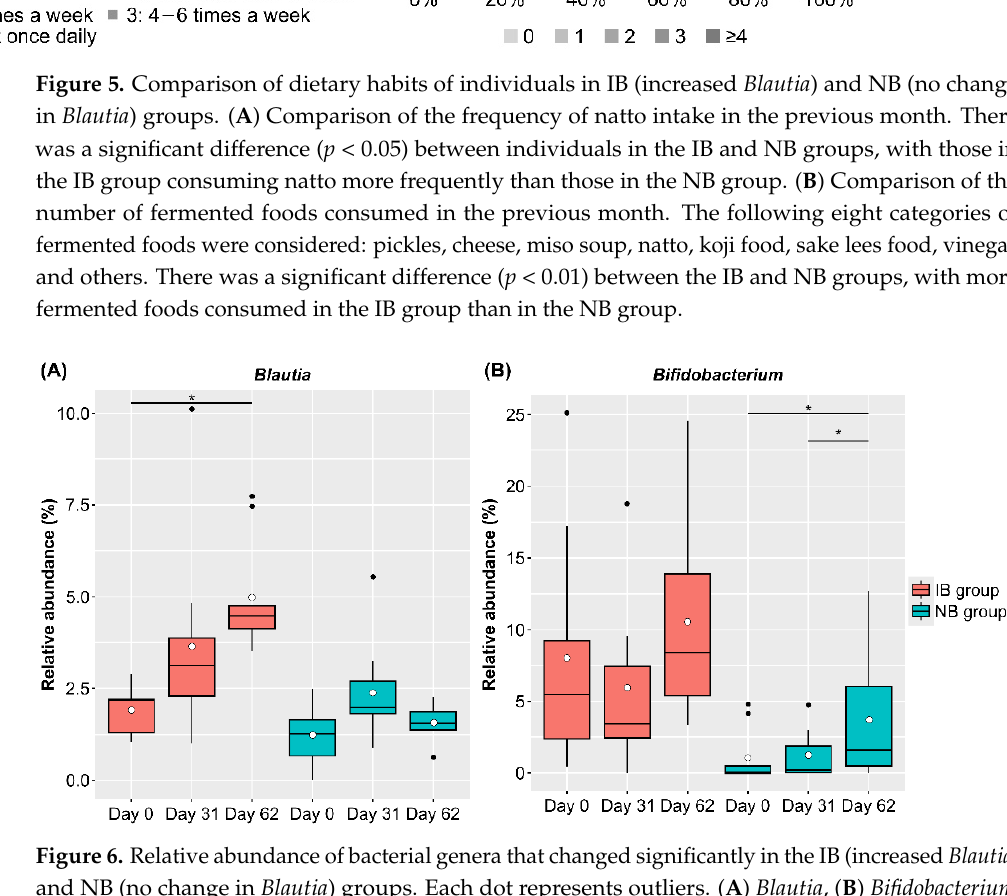
Figure 6. Relative abundance of bacterial genera that changed significantly in the IB (increased Blautia ) and NB (no change in Blautia ) groups. Each dot represents outliers. ( A ) Blautia , ( B ) Bifidobacterium . Comparison of CLR-transformed abundance of each genus using the ALDEx2 pipeline showed that Blautia abundance in the IB group was significantly higher on Day 62 than on Day 0, while Bifidobacterium abundance in the NB group was significantly higher on Day 62 than on Day 0 and on Day 31. * p < 0.05.